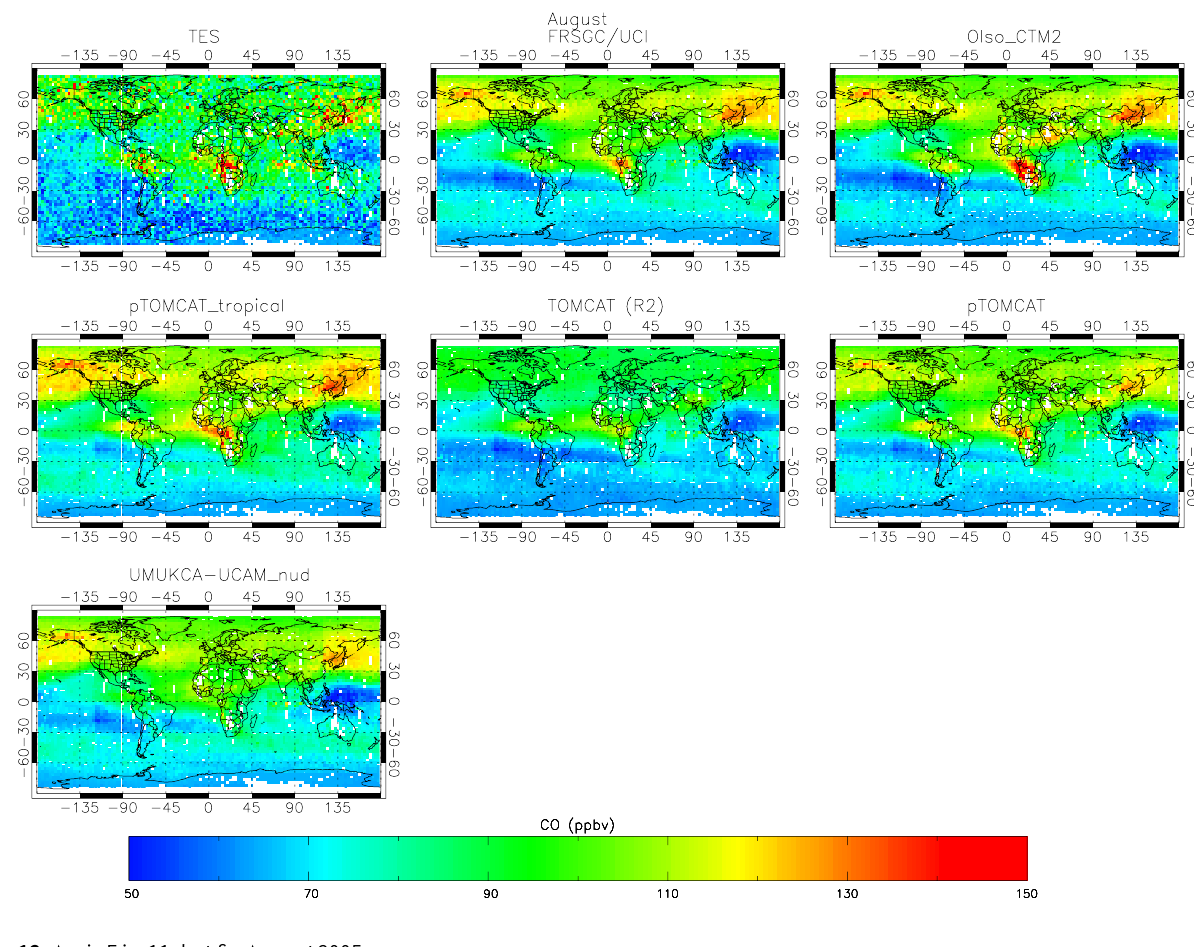
Fig. 12. As in Fig. 11, but for August